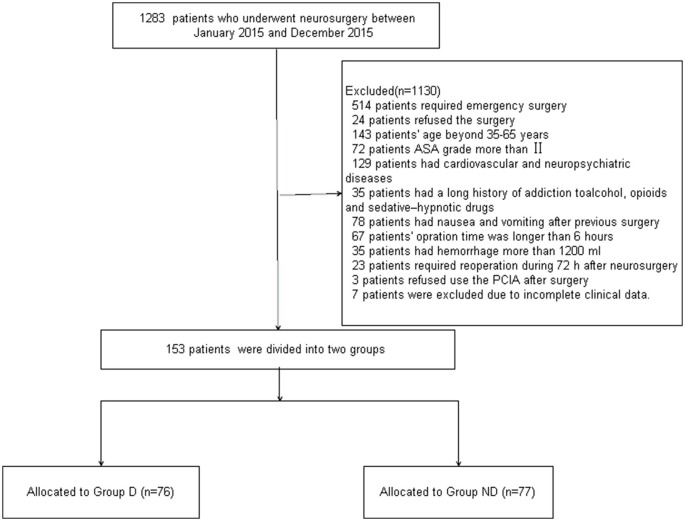
Patient enrolment flow diagram.